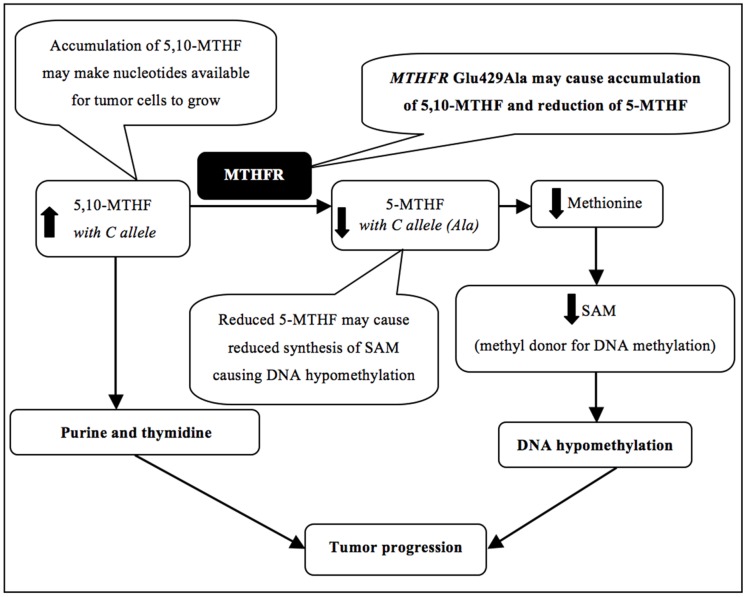
5,10-MTHF: 5,10-methylene tetrahydrofolate, 5-MTHF: 5-methyl tetrahydrofolate, MTHFR: methylene tetrahydrofolate reductase, SAM: S-adenosyl methionine.Arrows indicate the potential consequences of the polymorphism on biological processes depicted.